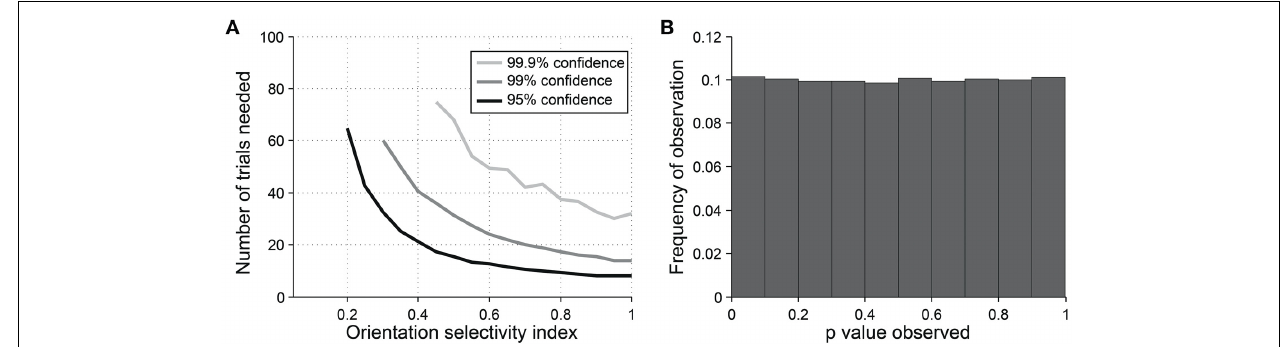
FIGURE 8 | Sensitivity and specificity of Hotelling’s T-squared test for detecting orientation selectivity. (A) Repeated simulations were performed with a single cell at different levels of underlying OI and different numbers of trials. 16 angles (22.5 ◦ steps) were used; noise = 40% at all conditions. Sensitivity of Hotelling’s T-squared test was measured at three levels of significance: 95, 99, and 99.9%. For example, the black line shows the